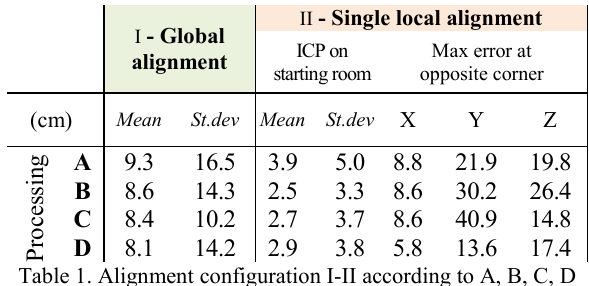
Table 1. Alignment configuration I-II according to A, B, C, D processing